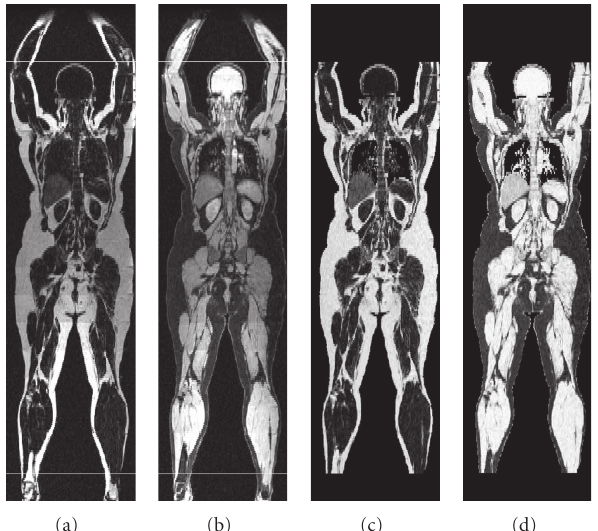
Figure 1: Illustration of image data employed from one subject included in the study. Reconstructed fat and water images are shown in (a) and (b), respectively. The horizontal lines delineate the subvolumes analysed in (c) and (d), where the fat- [fat/(fat+water)] and water-fraction [water/(fat+water)] images calculated and used to estimate total fat and water volumes are shown, respectively. Note that the intensity variations seen in (a) and (b) are removed by the use of fraction images. The intensity in each pixel estimates its absolute fat and water contents, and by integrating the pixel contents, total volumes are obtained. Note that fat infiltration of the liver (greyish and measured to approximately 25%) can be seen in (c).